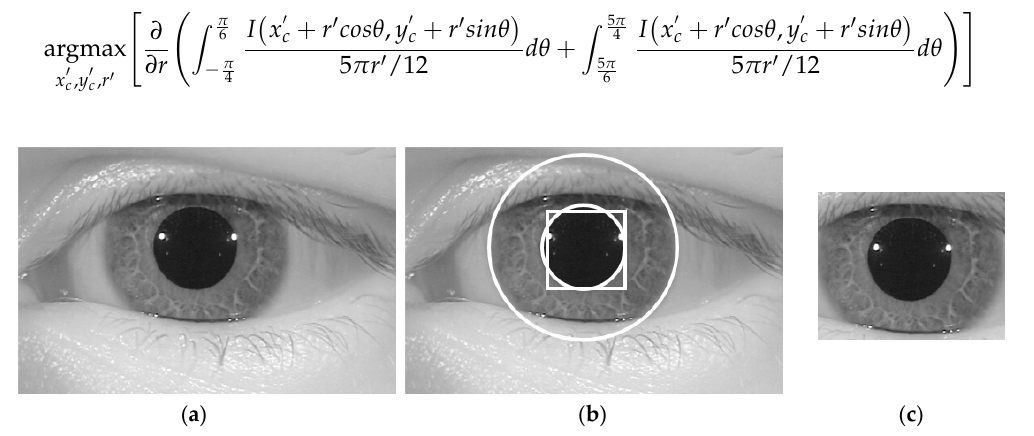
Figure 4. Example of detection results of pupil and iris boundary detection method: ( a ) input iris image; ( b ) detection results of sub-block-based pupil detection (rectangular box) and CED for pupil and iris region detection; and ( c ) final iris image to input iPAD system.